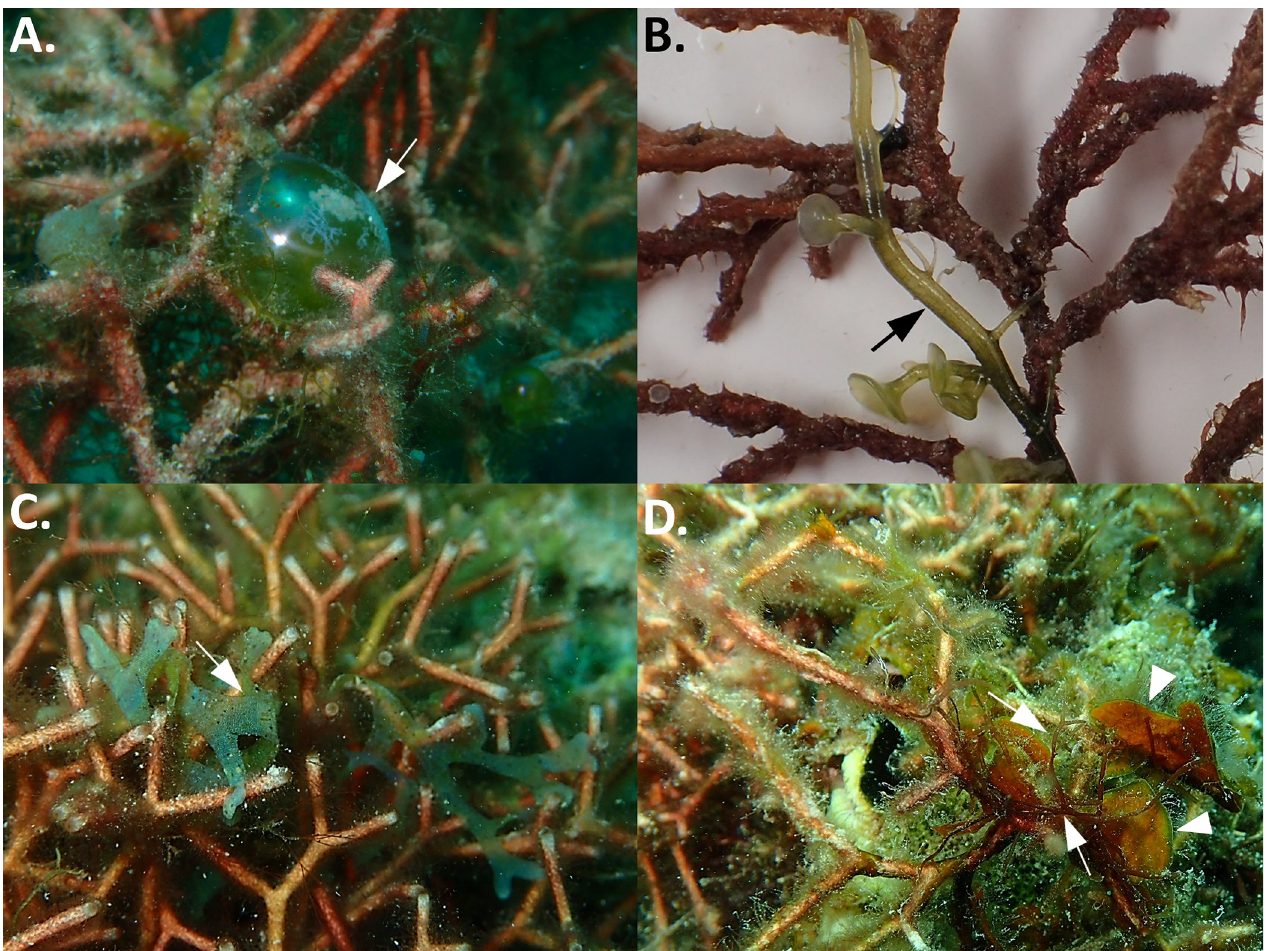
Fig 6. Examples showing epiphytic macroalgae that frequently grow on G . divaricata . A) Valonia ventricosa , B) Caulerpa chemnitzia , C) Dictyota sp., D) Lobophora sp. (arrowhead), and Hypnea caespitosa